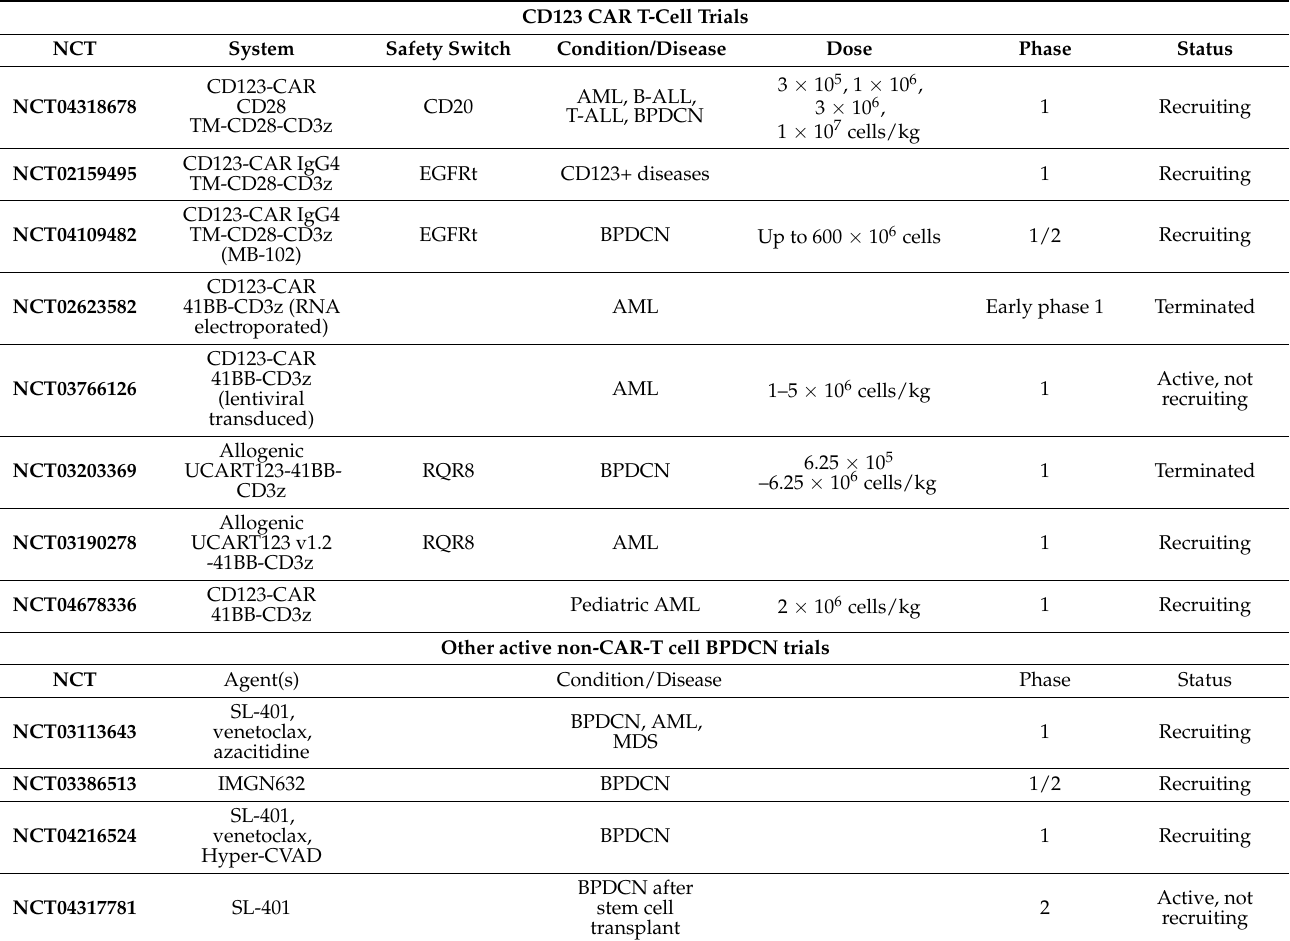
Table 1. Clinical trials using CAR-T cells targeting CD123 in patients with leukemia including BPDCN and active non-CAR-T cell BPDCN trials (extracted from clinicaltrials.gov (accessed on 21 March 2022)). CD123 CAR T-Cell